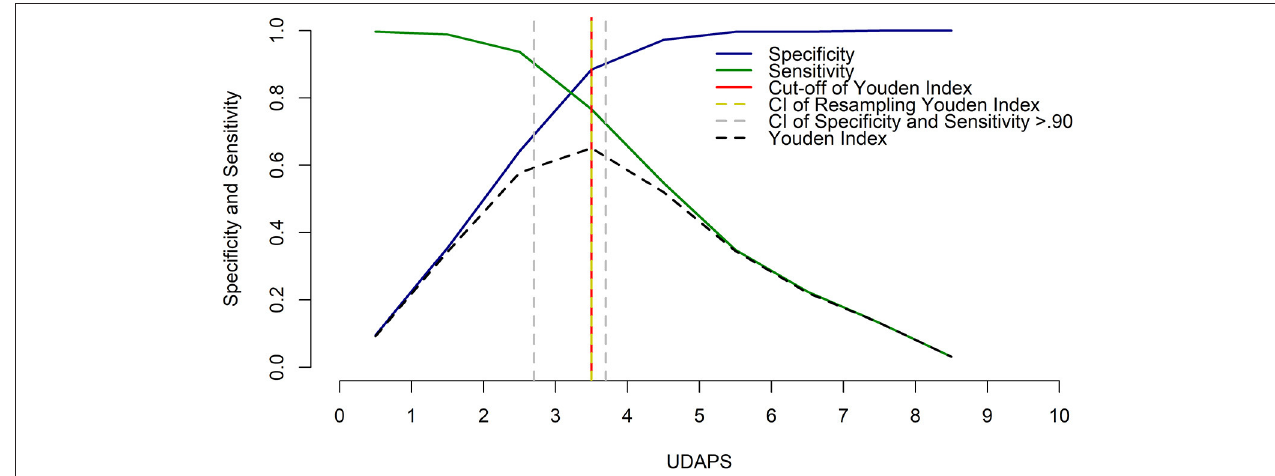
FIGURE 3 | Two-graph ROC curve for the DOPS with the Youden index and diagnostic uncertainty zone of the cut-off point based on the confidence interval (CI) between the sensitivity and specificity values of